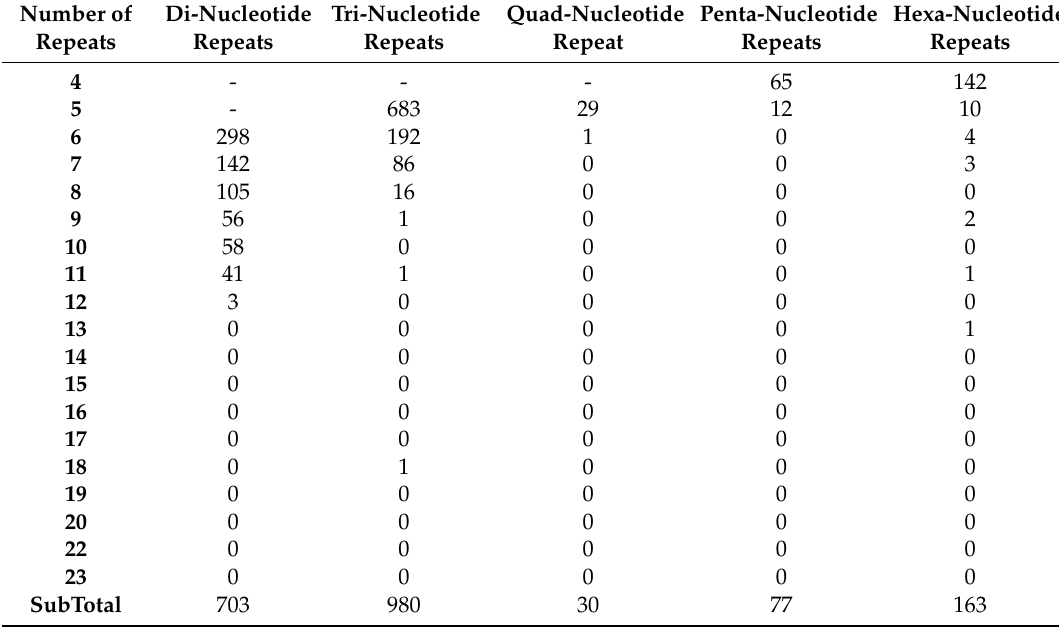
Table 2. Distribution of SSR